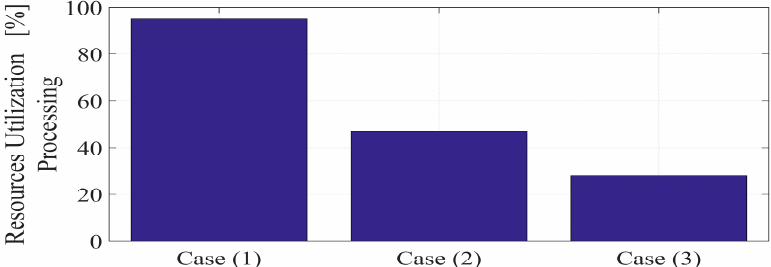
Figure 7. The average resources utilization in terms of storage for the considered simulation cases.